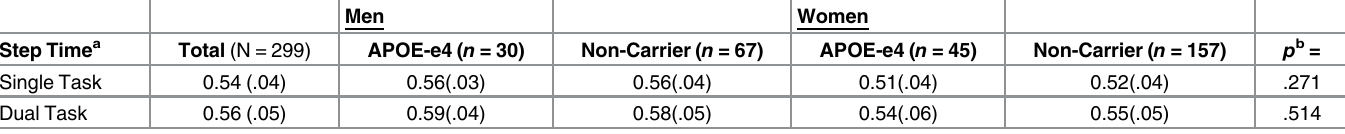
Table 4. Group means and standard deviations for gait step time by task condition, sex and